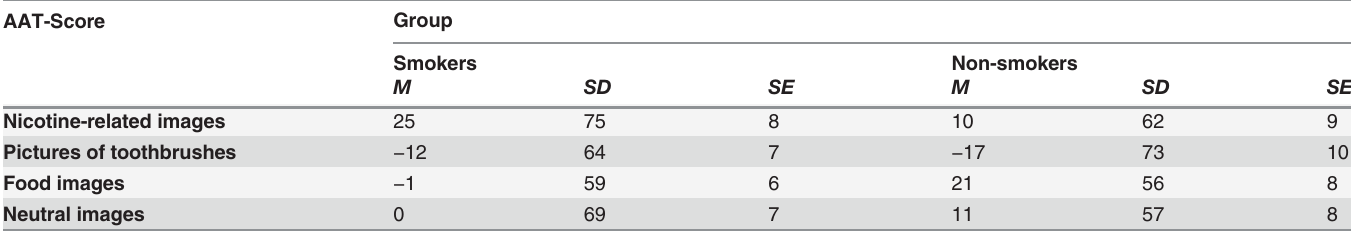
Table 2. Mean AAT-bias-scores for smokers and non-smokers per image